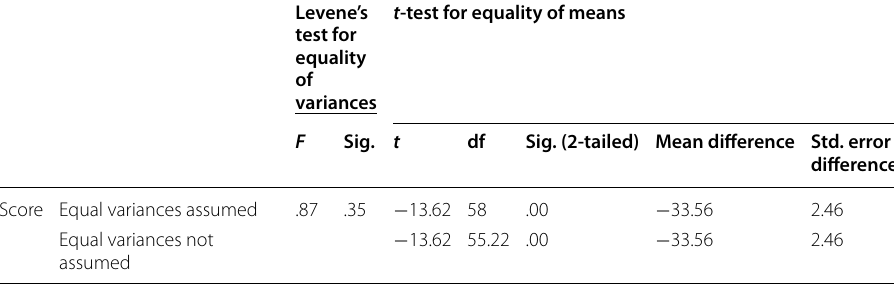
Table 19 Inferential statistics (anxiety post‑test of both groups)